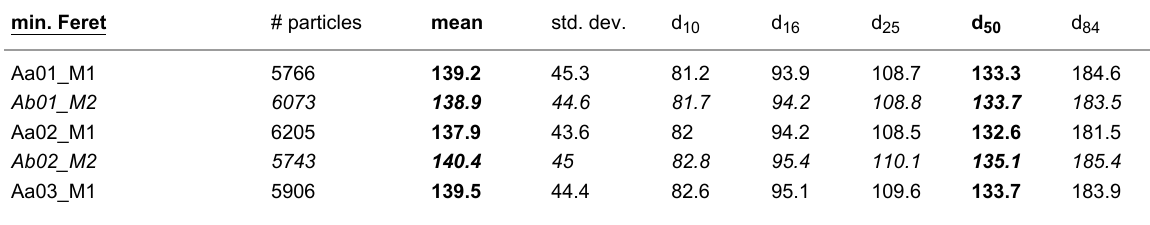
Table 4: Evaluation of the primary particle sizes of KRONOS K1171 in terms of the minimum Feret diameter; all values given in nm. min. Feret